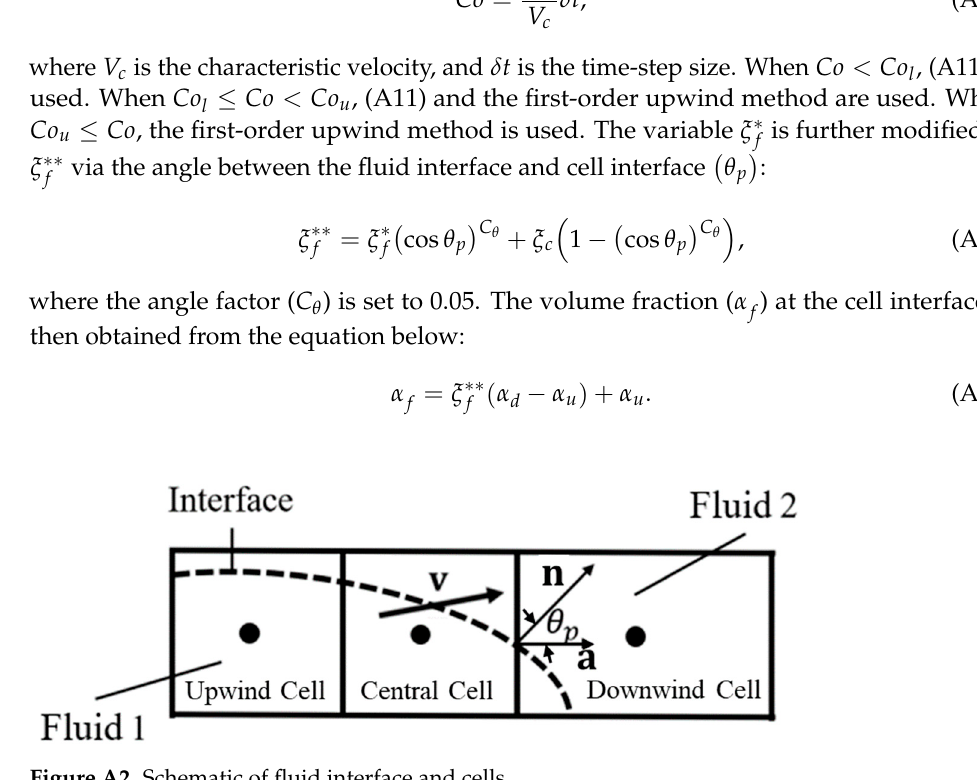
Figure A2. Schematic of fluid interface and